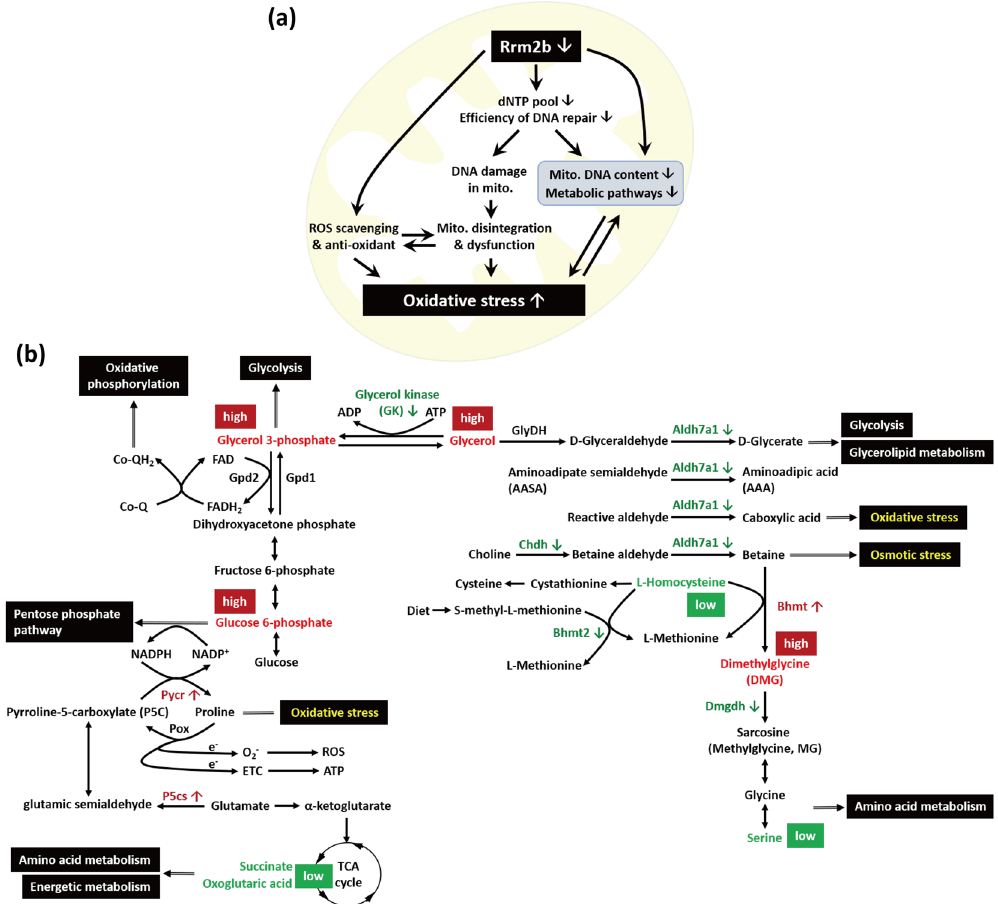
Figure 5. Schematic of mechanistic effects of Rrm2b deficiency in kidney. ( a) The critical effects of Rrm2b deletion, based on previous reports and this study. (b) Schematic of pathways for Rrm2b-related metabolism under Rrm2b deficient condition. Red indicated the metabolites or enzymes that have higher expression, and green indicated the metabolites or enzymes that have lower expression in Rrm2b kiKO mice. Dimethylglycine dehydrogenase (Dmgdh; Me2GlyDH, matrix); Betaine homocysteine methltransferase (Bhmt, cytosol); Betaine homocysteine methltransferase 2 (Bhmt2, cytosol); NAD + -linked betaine aldehyde dehydrogenase (Aldh, matrix); Choline dehydrogenase (CHDH, inner cell membrane); Glycerol-3-phosphate dehydrogenase 1 (Gpd1, soluble, cytosol); Glycerol-3-phosphate dehydrogenase 2 (Gpd2, matrix); Glycerol dehydrogenase